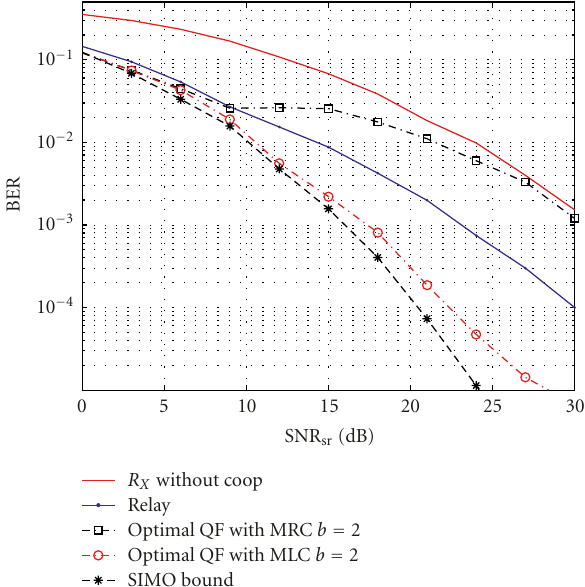
Figure 7: Influence of of the combining scheme for the opti- mal QF scheme ( b = 2) in quasistatic channels with { SNR rd = 40dB,SNR sr = SNR sd + 10dB } .